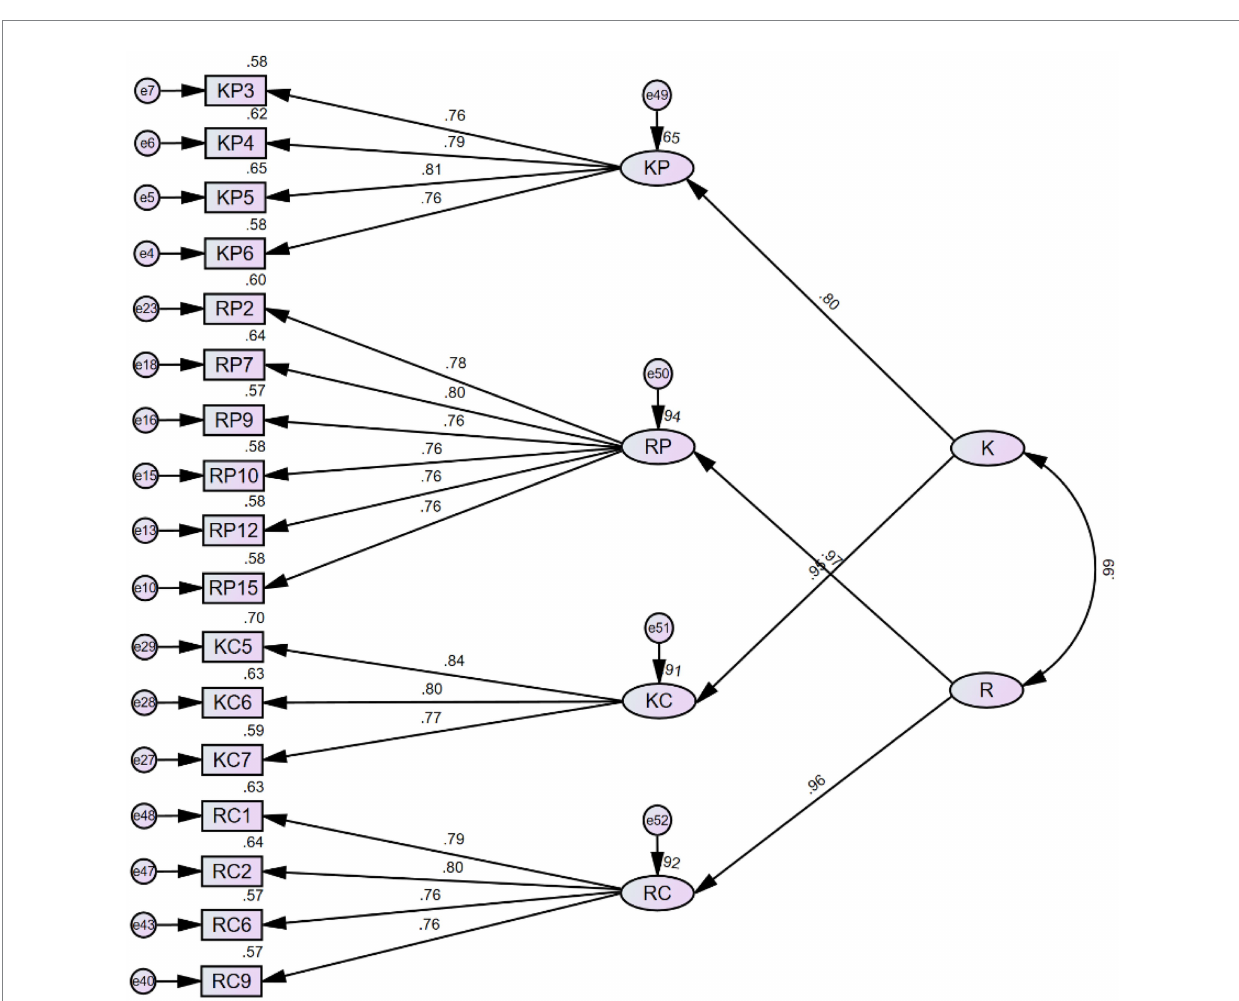
FIGURE 4 Model 4 with metacognition as the second-order factor. K stands for knowledge of cognition and R stands for regulation of